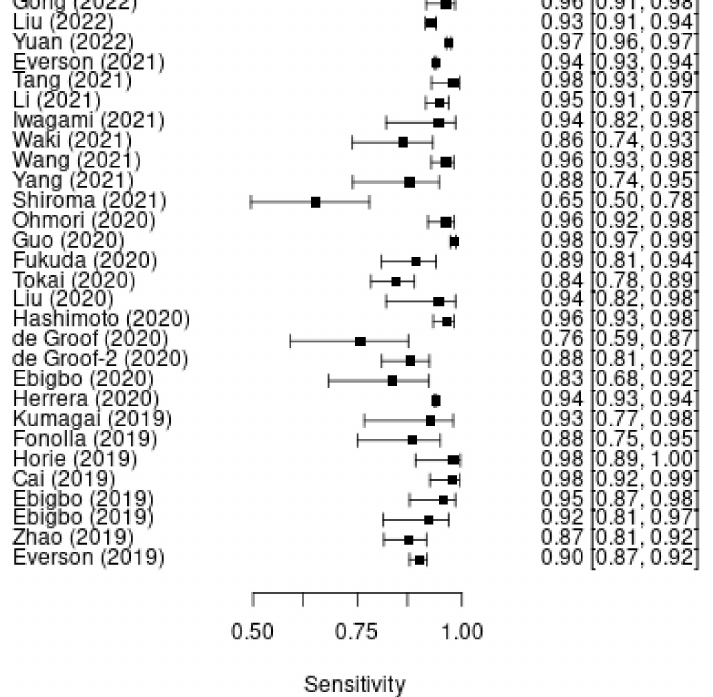
Figure 1. Pooled sensitivity of the DL model for the diagnosis of esophageal cancer.